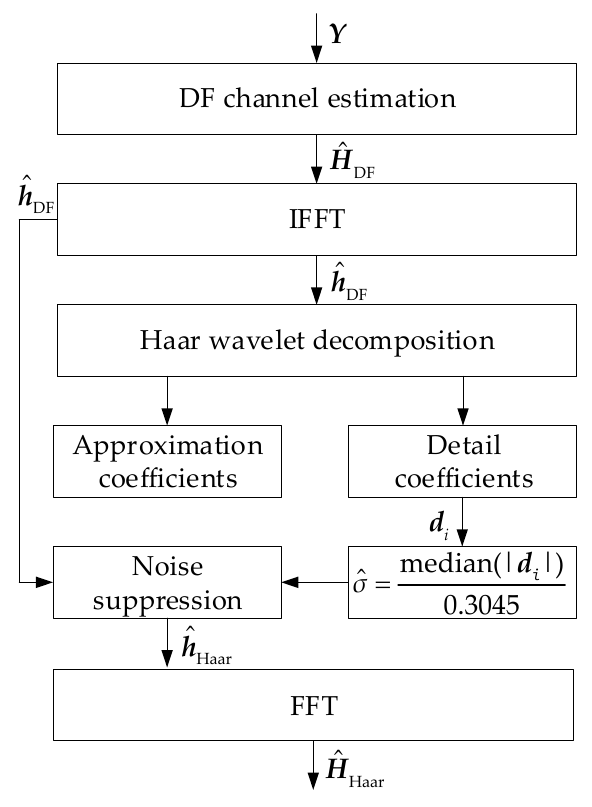
Figure 4. The proposed Haar wavelet channel estimation method in wavelet-OFDM system.